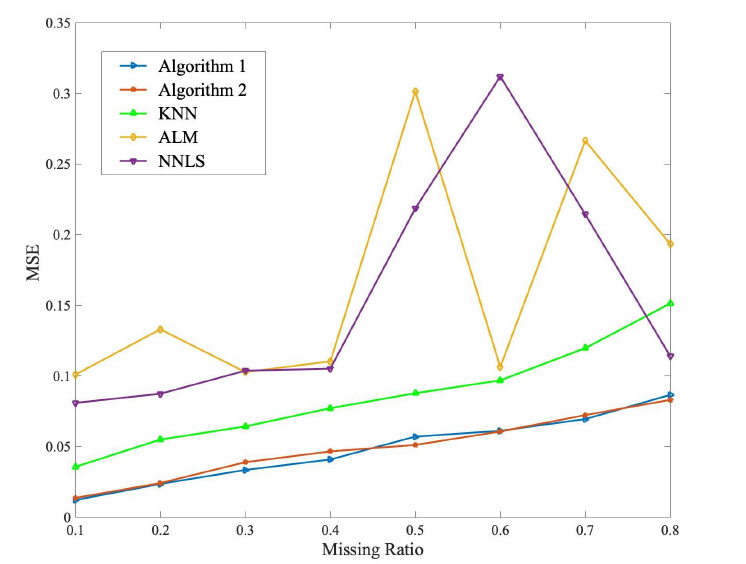
Figure 6. The MSE comparison for different methods under different missing ratios.